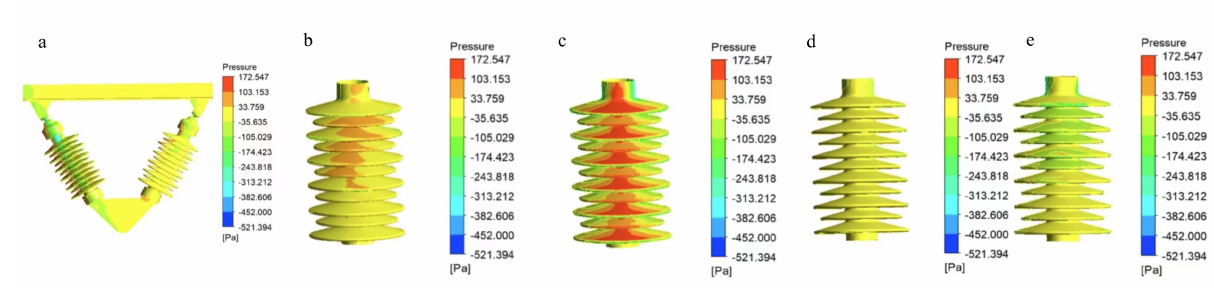
Figure 10. Static pressure distributions on the insulator surface under the wind speed of 15 m/s. ( a ) the surface pressure distributions on the crosswind side of insulators; ( b ) the surface pressure distributions on the windward surface of 2# insulator; ( c ) the surface pressure distributions on the windward surface of 1# insulator; ( d ) the surface pressure distributions on the leeward surface of 2# insulator; ( e ) the surface pressure distributions on the leeward surface of 1# insulator.